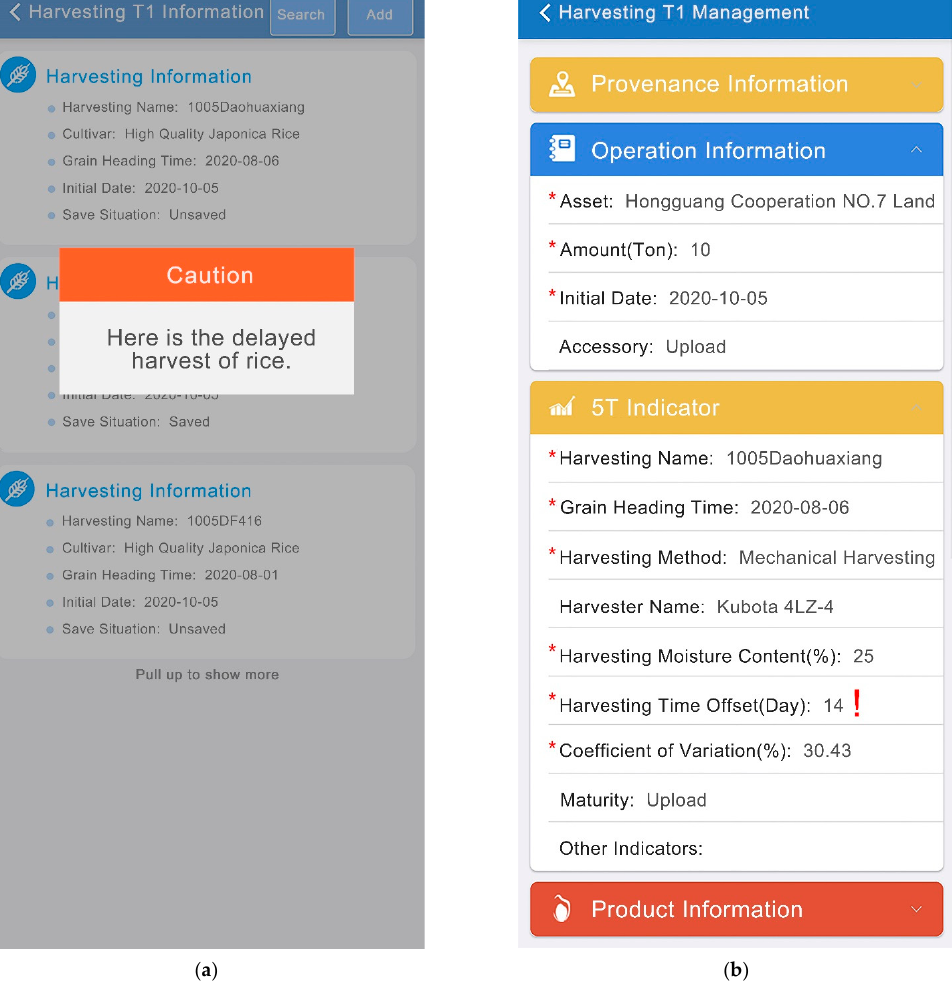
Figure 13. Delayed harvesting prompt interface of the mobile terminal. * indicates necessary indicator. ! indicates this indicator may be in question. The effector receives signals based on mirrored event information. In har- vesting (T 1 ), the GPS-guided harvester harvests crops with high precision and automatically measures yields, which reduces resource energy consumption and increases production intensity. In field stacking (T 2 ) and warehousing (T 4 ), it plans navigation paths, reducing environmental footprints. In drying